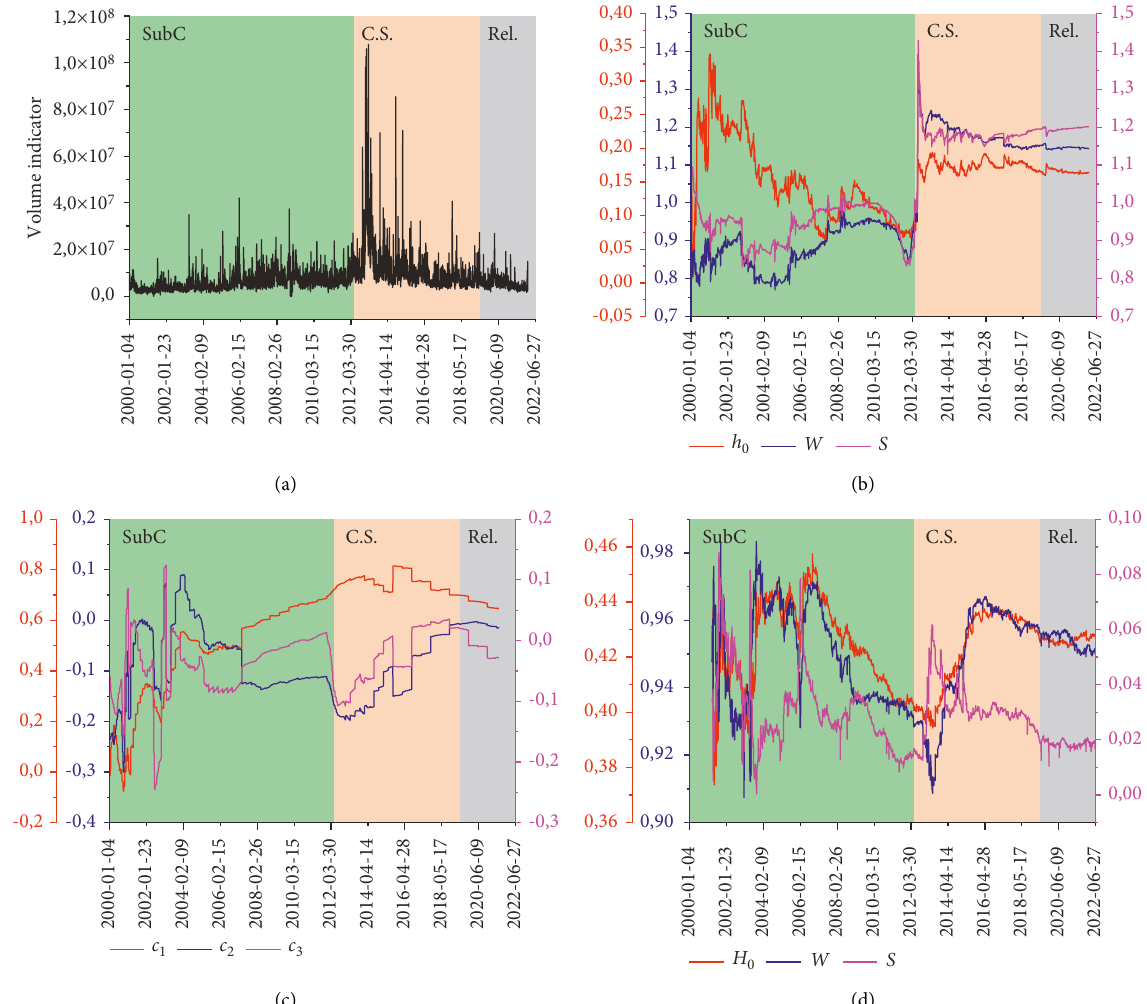
Figure 3: Time series of the log-cumulants ( c facilitated rules of the Manna